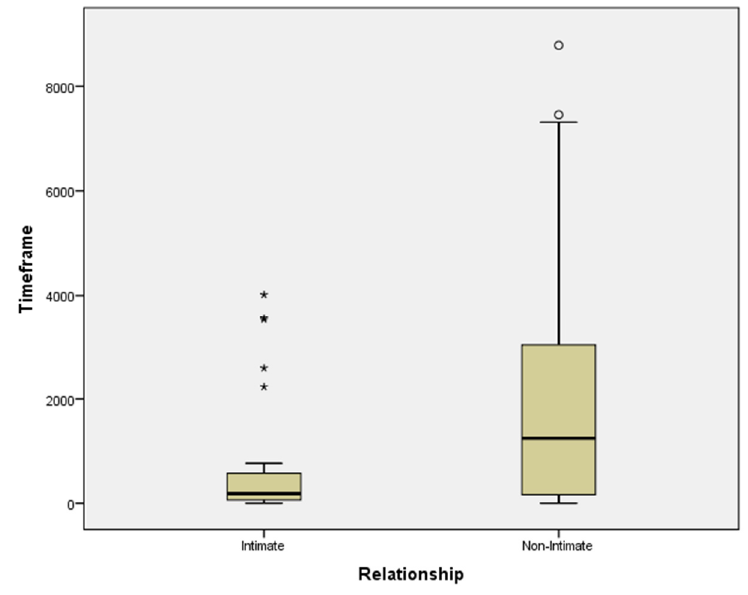
Figure 3. Homicide offenders and timeframe with suicide considering the relationship with the victims (Intimate/Non-Intimate). * indicated the inmates’ suicide cases distribution considering Intimate relationship ° indicated the inmates’ suicide cases distribution considering Non- Intimate relationship.